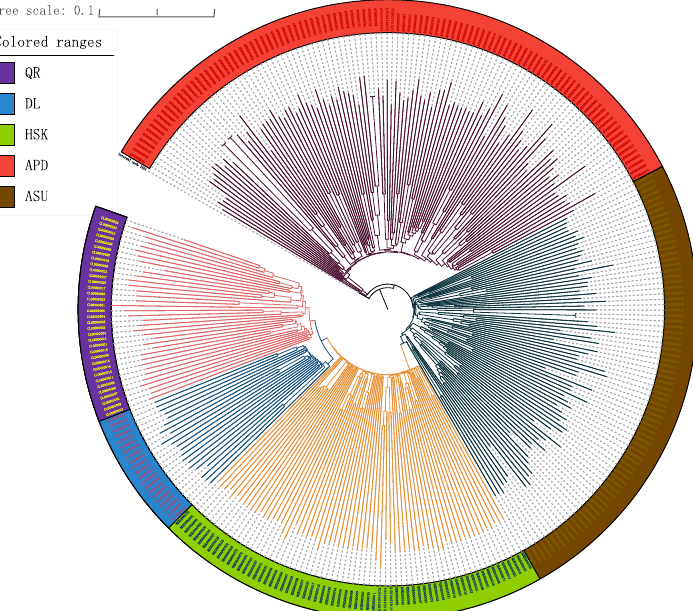
Figure 2. Evolutionary tree of five sheep breeds. Red represents APD, brown represents ASU, light green represents HSK, blue represents the DL and purple represents QR.